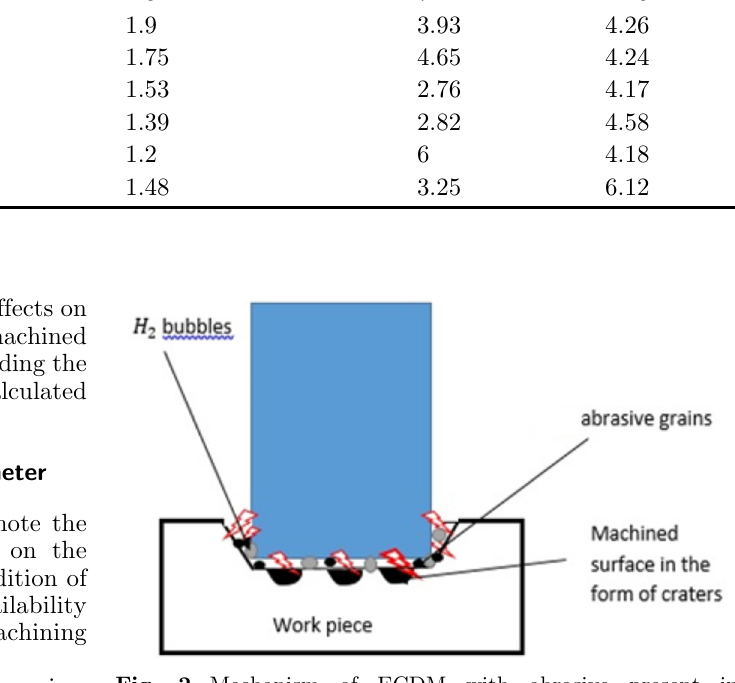
Aspect ratio Aspect ratio O with Al with 2 3